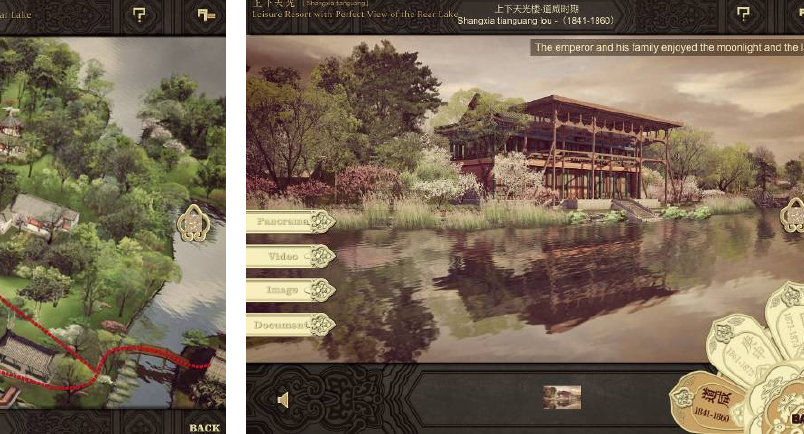
Figure 8. Rendered image of the same site, showing a later state the monument (1841-1860)